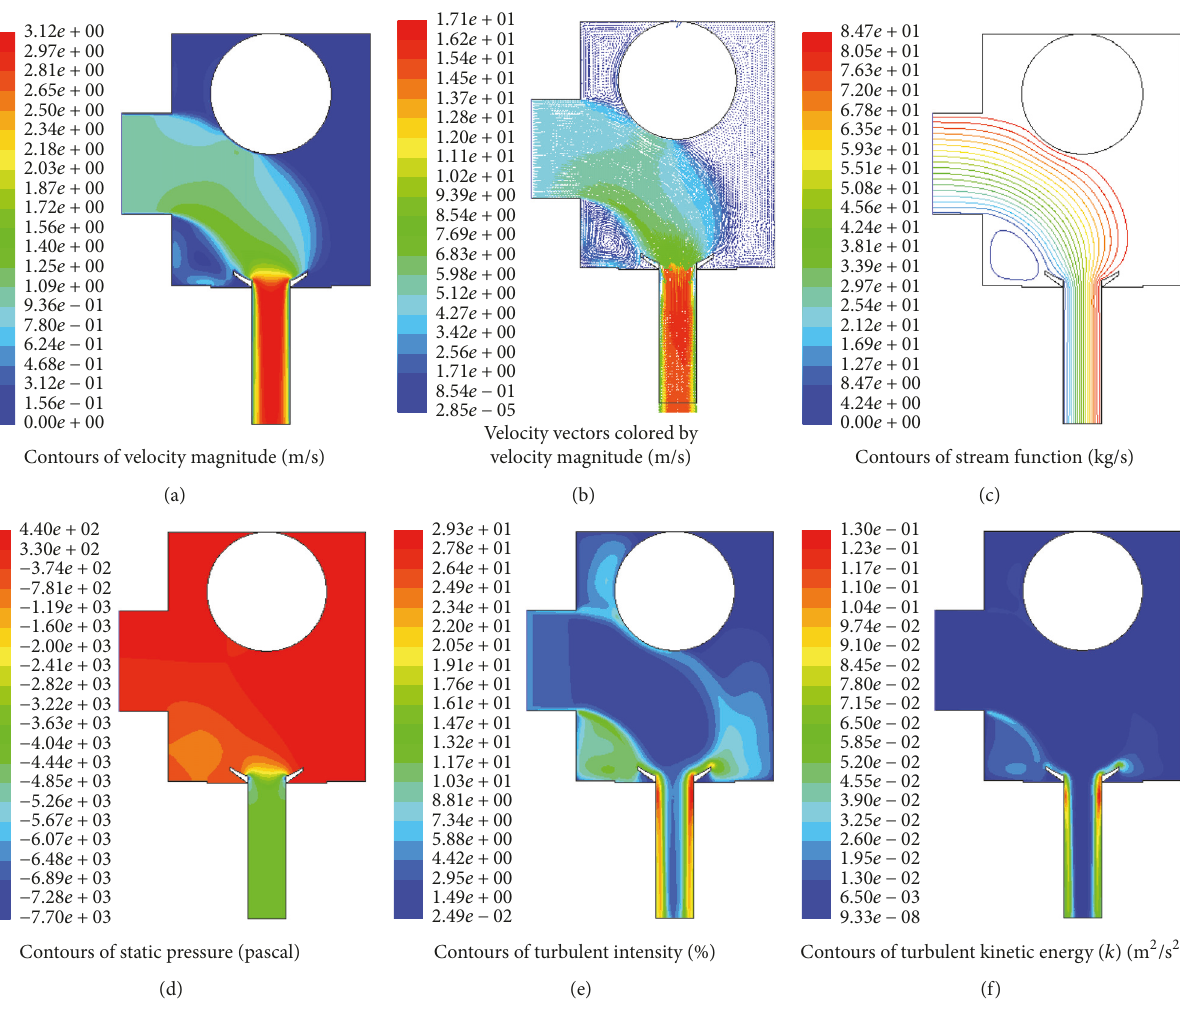
Figure 6: (a) Contours of velocity magnitude; (b) contours of velocity vector; (c) contours of stream function; (d) contours of static pressure; (e) contours of turbulent intensity; (f) contours of turbulent kinetic energy in drainage device at T6